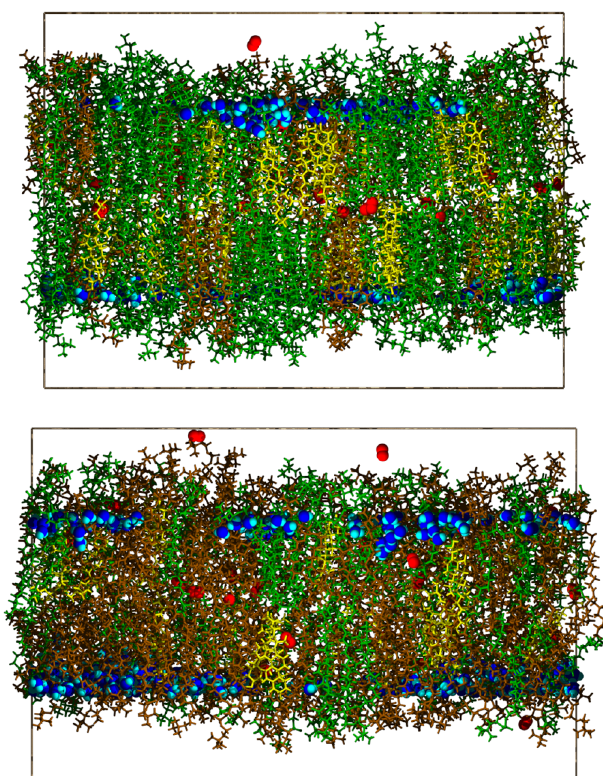
Fig. 9 Simulation snapshots of DPPC/DOPC/chol. The liquid ordered and liquid disordered are shown in the top and bottom, respectively. Coloring as follows: DPPC (green); DOPC (brown); cholesterol (yellow); oxygen (red); waters between the phosphate planes of the bilayer (blue oxygen and cyan hydrogen). Other waters, all ions, and atoms in half of the box are omitted for clarity. The boundaries of the periodic cells are shown in solid